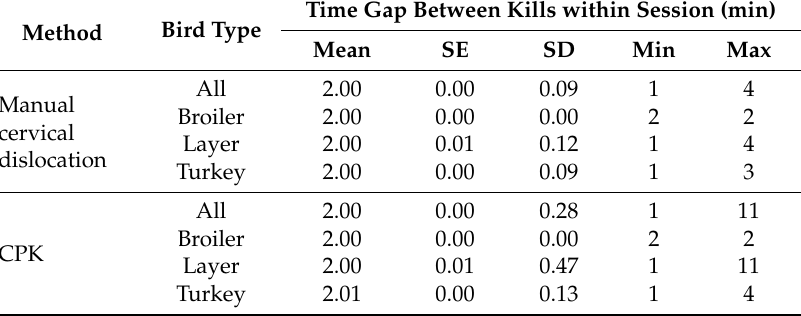
Table 1. Descriptive statistics (mean, SE, SD, minimum, and maximum) for the time gap between kills within sessions for each kill method. CPK = Cash Poultry Killer